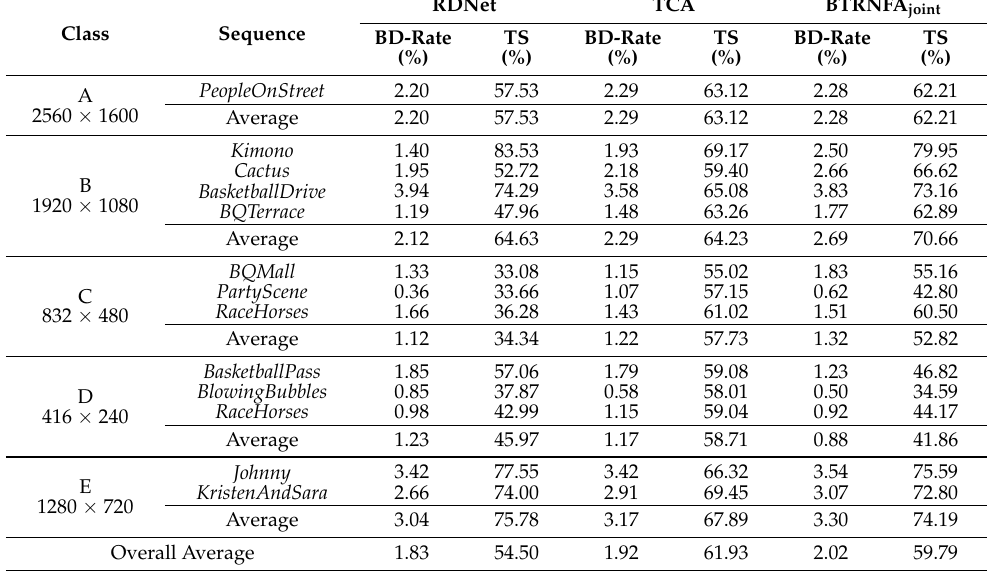
Table 10. Encoding performance comparison with RDNet and